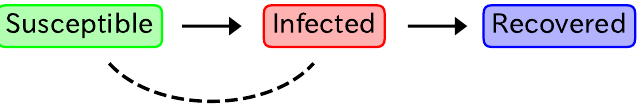
Figure 4. The illustration of the scheme of the SIR